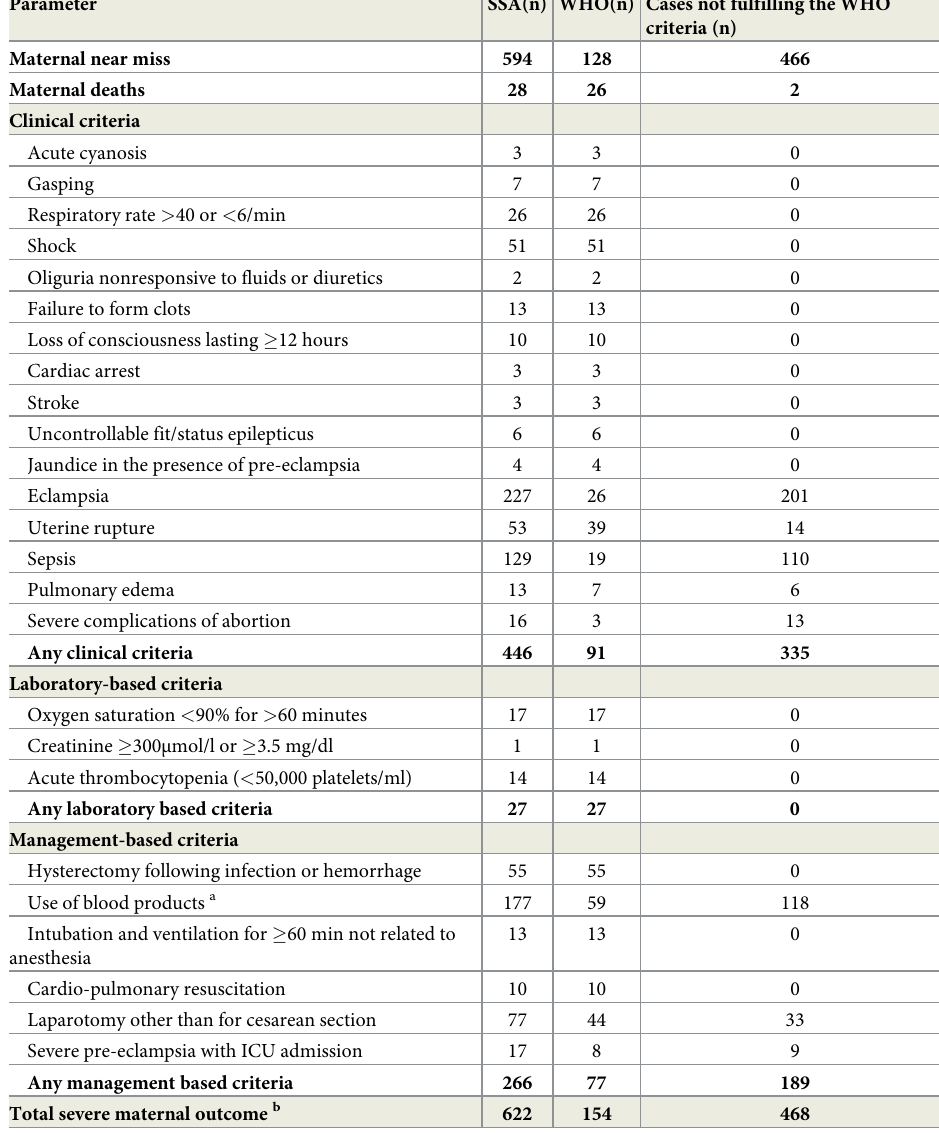
Table 3. Distribution of MNM according to the sub-Saharan and WHO criteria.